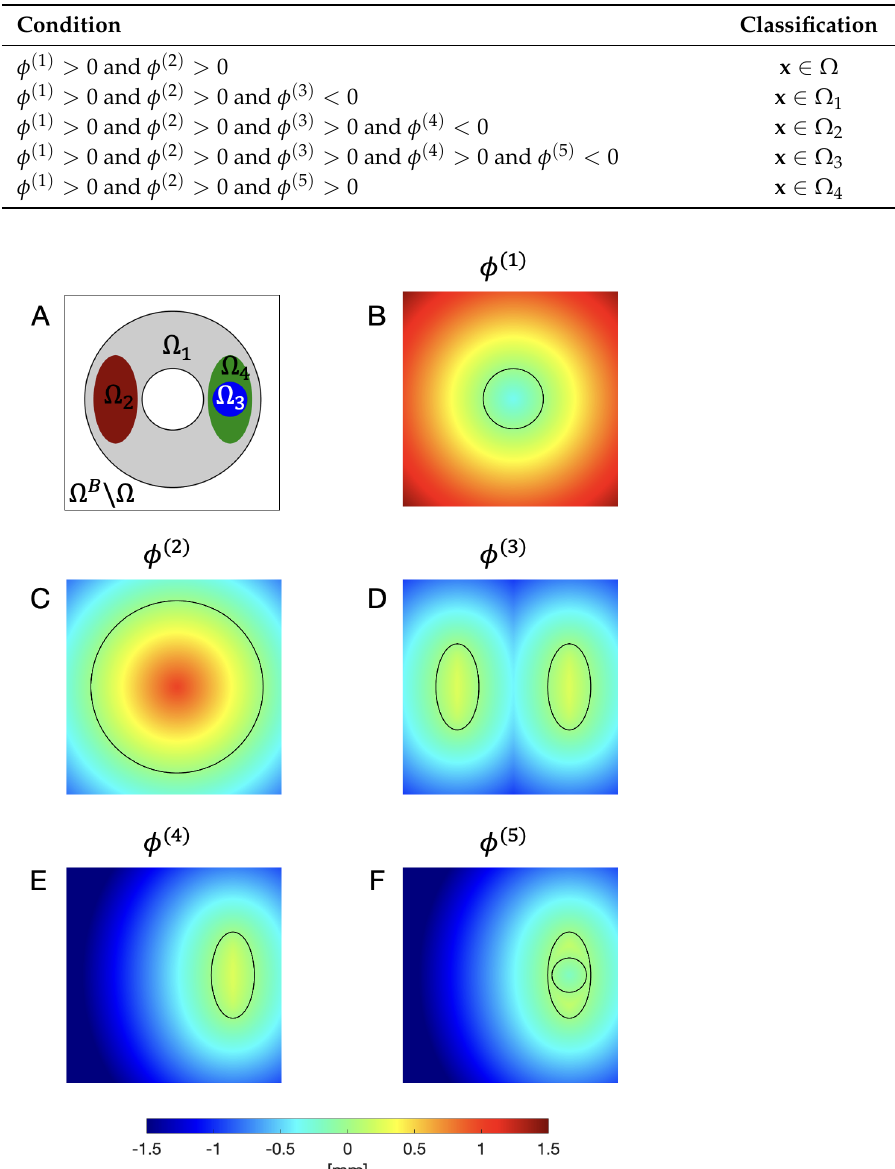
Figure 3. ( A ) Ω embedded in Ω B . Level set ( B ) φ ( 1 ) = 0 describes Γ N , and ( C ) φ ( 2 ) = 0